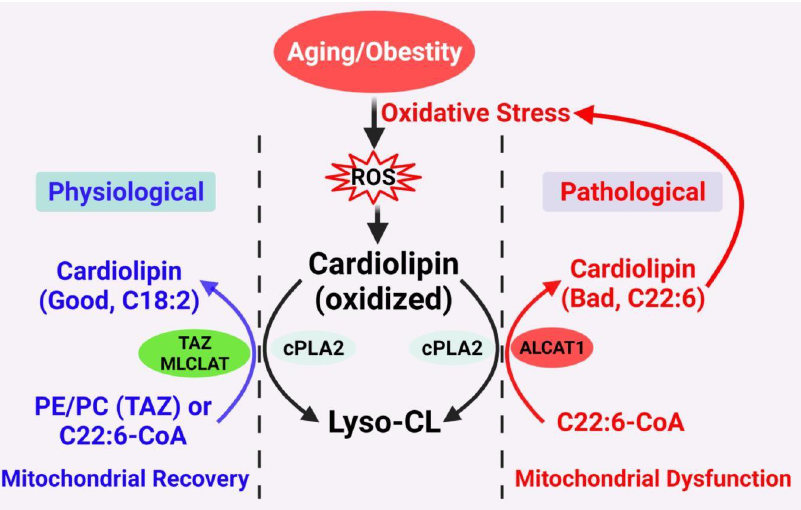
Figure 2. Proposed CL remodeling pathways in obesity and aging. Aging and obesity cause oxidative stress, leading to the production of ROS. CL oxidation by ROS triggers the remodeling of its fatty acyl chains, which begins with hydrolysis of oxidized CL by phospholipase A2 (cPLA2), followed by acylation of lysocardiolipin by either tafazzin (TAZ), MLCLAT, or ALCAT1. TAZ is a transacylase that catalyzes physiological remodeling of CL with other phospholipids, such as PC and PE, whereas MLCLAT catalyzes remodeling of CL with MLCL and linoleoyl-CoA, leading to mitochondrial recovery. ALCAT1 catalyzes remodeling of CL with both MLCL or dilysocardiolipin and docosahexaenoic-CoA (C22:6) as substrates, leading to CL peroxidation by ROS and mitochondrial dysfunction.